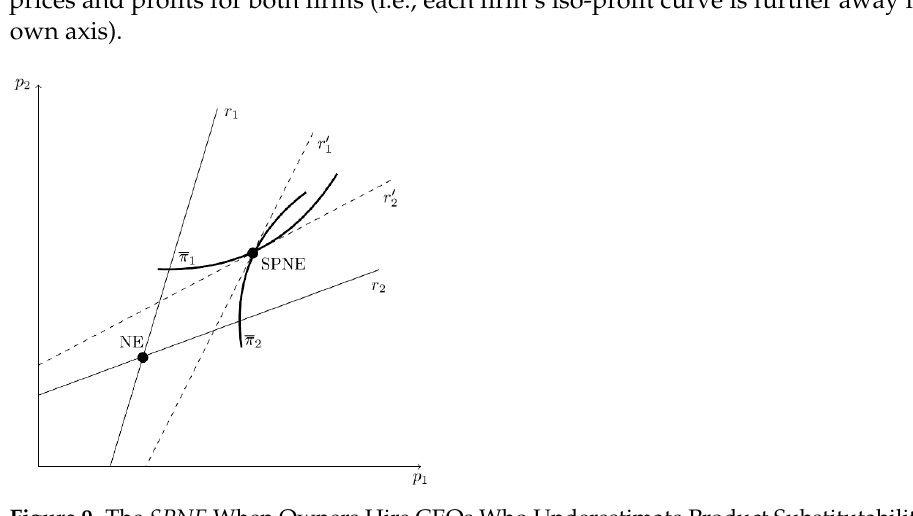
Figure 9. The SPNE When Owners Hire CEOs Who Underestimate Product Substitutability in the Bertand Model.